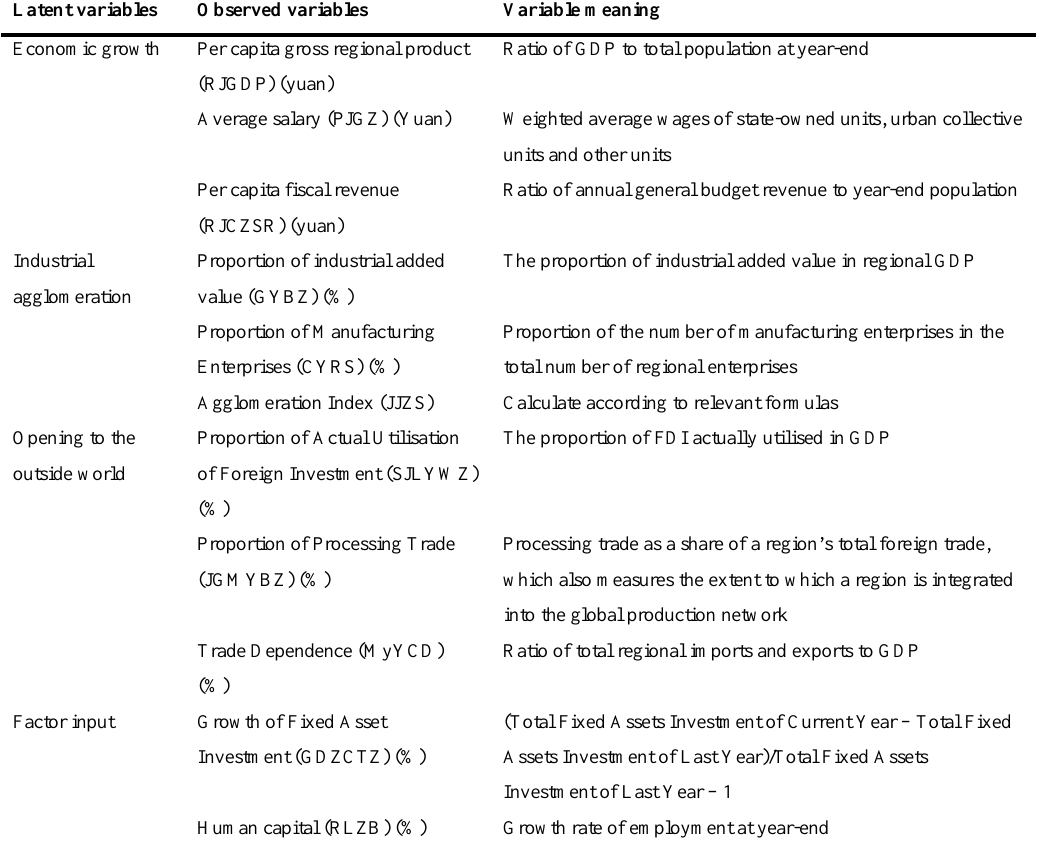
Table 1 Connotation analysis of latent variables and observed variables